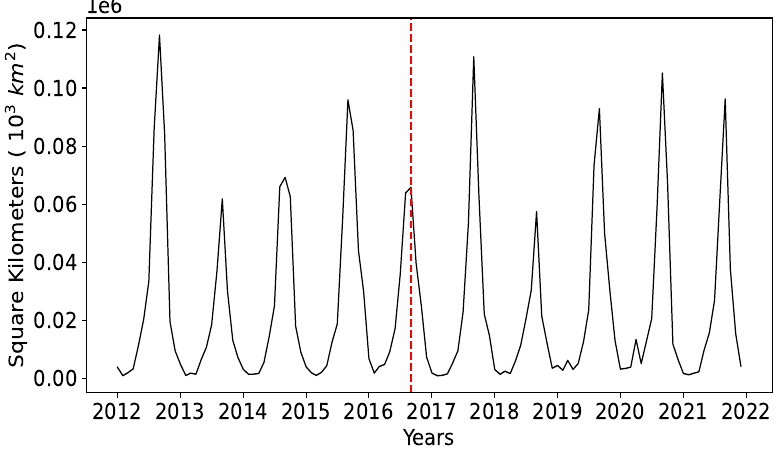
Figure 1. The fires TS before seasonality.